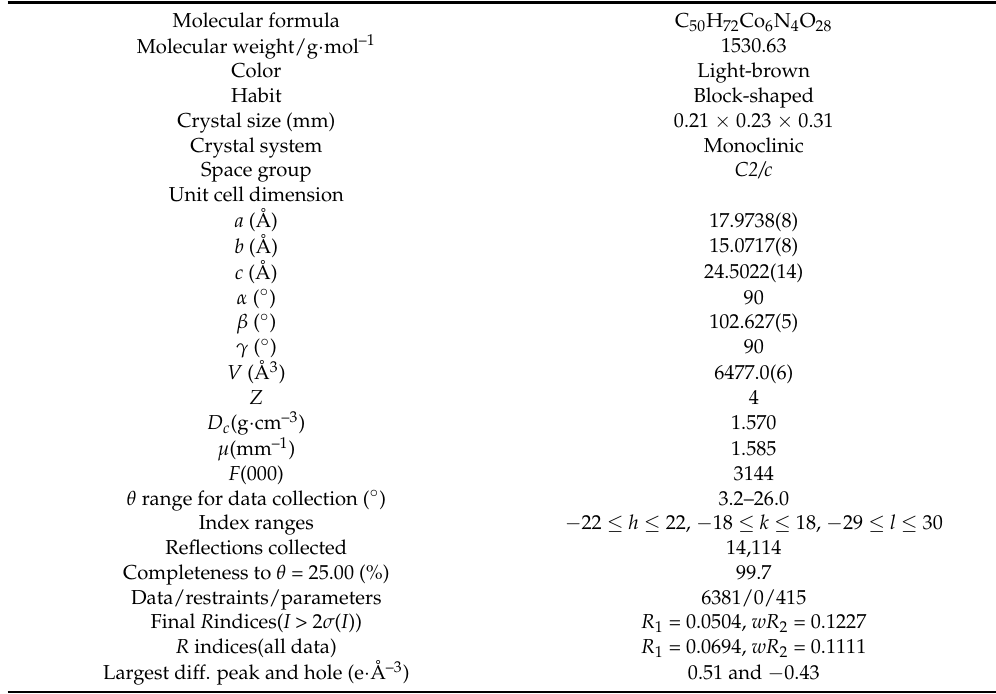
Table 1. Crystallographic and structural refinement data for the Co(II) coordination